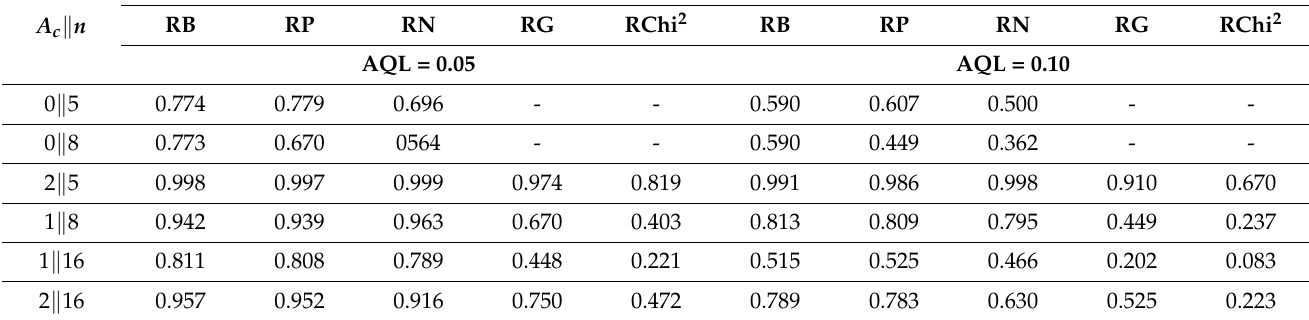
Table 1. The values of the acceptance probability estimated for various acceptance plans related to normal control and the transition from strict to normal control of the considered precast concrete products.